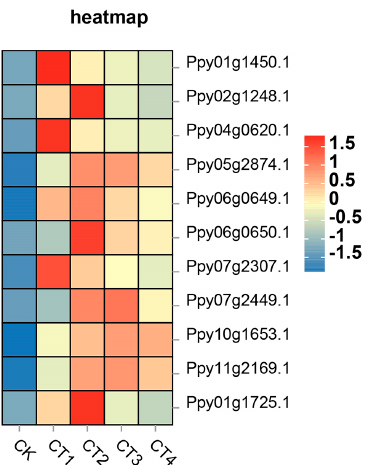
Figure 4. Heatmap of differential transcription factor expression.